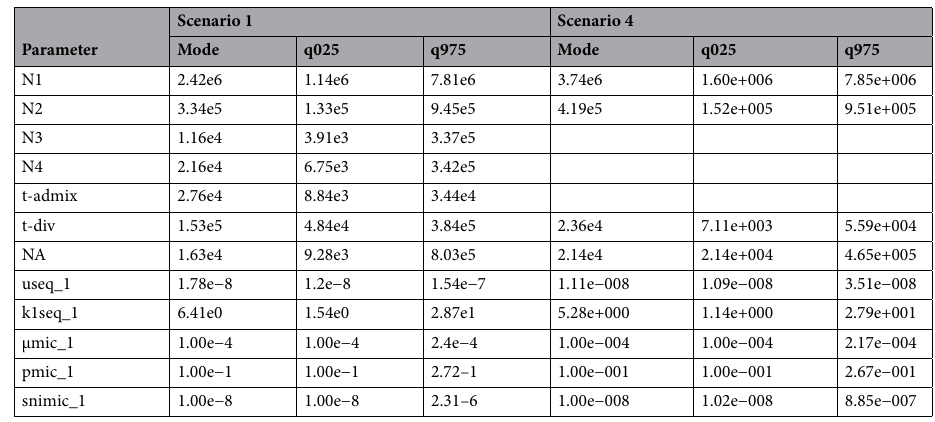
Table 4. Posterior probabilities for each of the demographic parameters of the scenarios one and four 95% confidence interval range are shown as lower boundary q025 (2.5%) and upper boundary q0975 (97.5%). N1 is the North population effective population size and N2 is that of the South population. N3 is the precursor population of the North population (before admixture) and N4 is the precursor population of the South population (before admixture). t-admix is the time of admixture and t-div is the time of divergence between the north and south lineages. NA is the ancestral effective population size. useq is the mitochondrial sequence mutation rate, k1seq is the number of haplotypes, µmic is the microsatellite mutation rate, and pmic and snimc are the larger than one step proportion of mutations and the non-standard mutation rate (e.g.